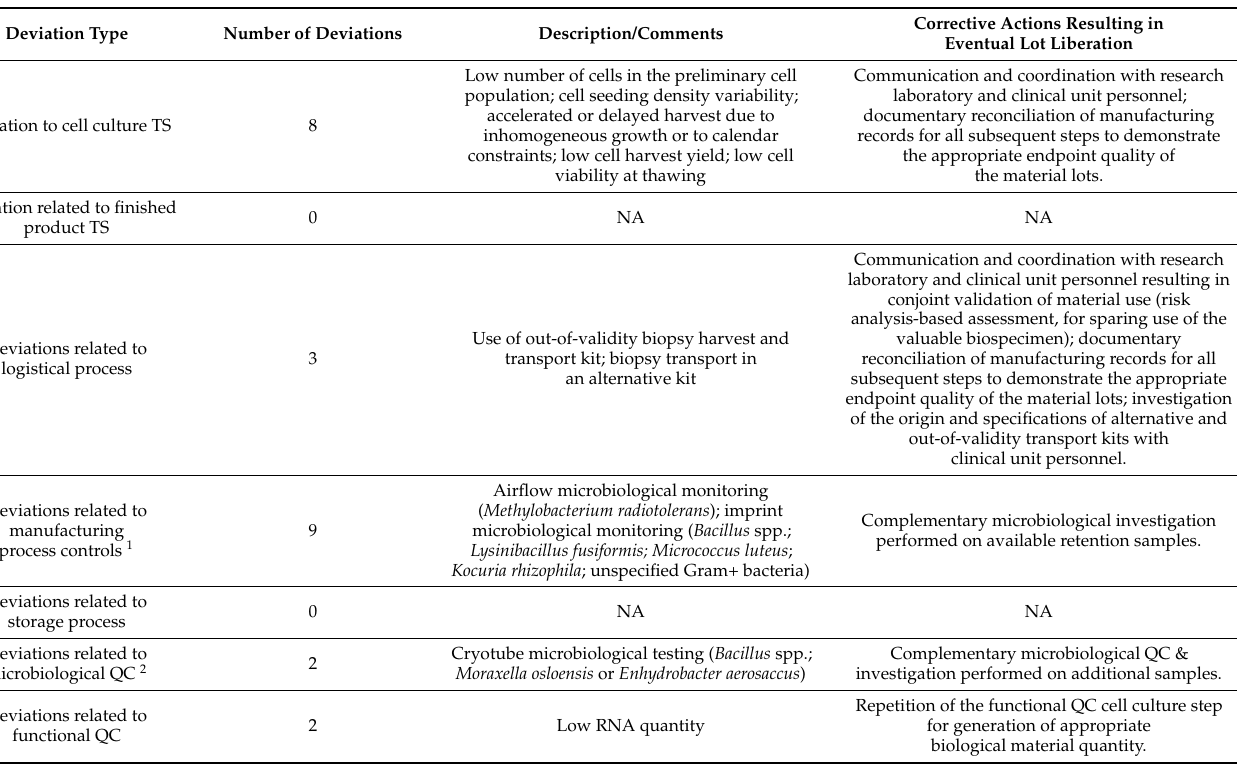
Table 2. Overview of the recorded GMP manufacturing process deviations for the 47 considered clinical HAC batches. Overall, a total of 8 deviations were qualified as minor, pertaining mostly to microbiological environmental monitoring or microbiological QC out-of-specification results for API manufacturing activities. Overall, a total of 5 deviations were qualified as major, pertaining mostly to biopsy transport conditions and to environmental microbiological monitoring